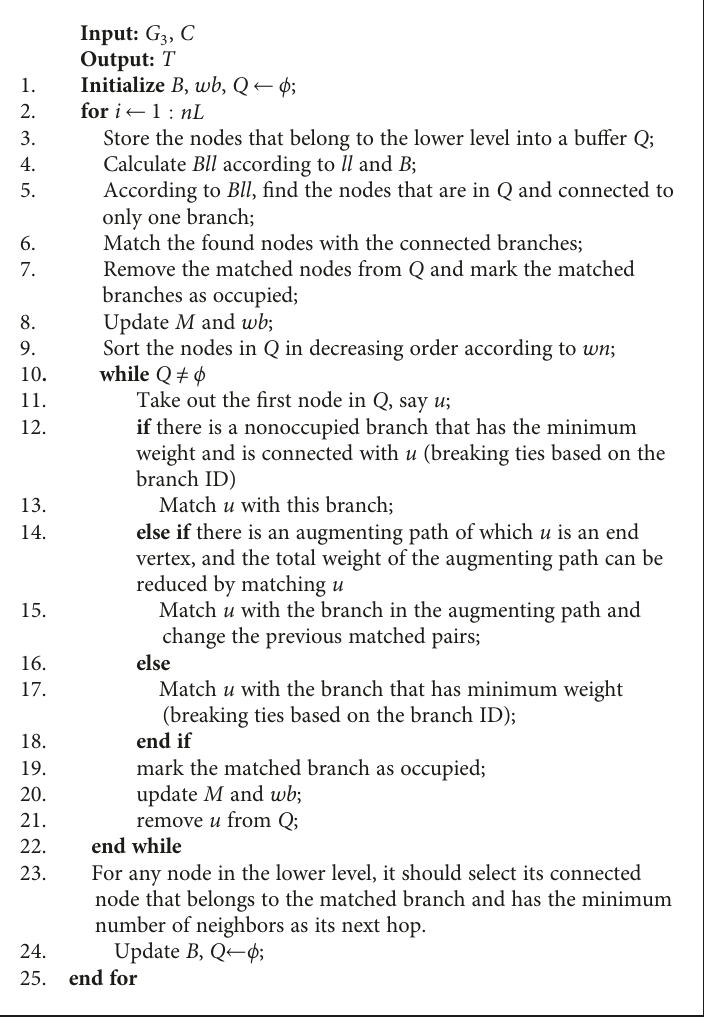
Algorithm 3: Construction of routing